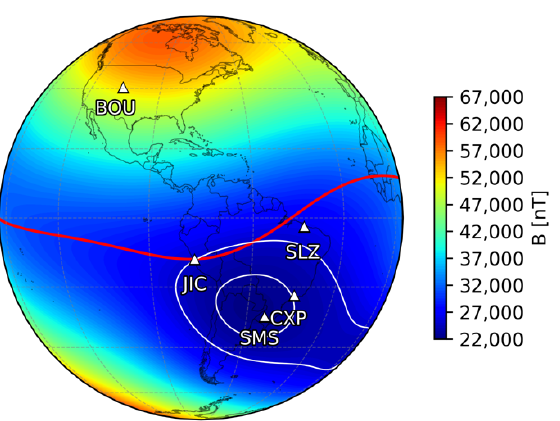
Figure 1. Map showing the instrument sites used in this study. The magnetic equator positions in 2017 (red line) and the SAMA location (white isolines) are also shown. The acronyms for the stations are: BOU, Boulder; JIC, Jicamarca; SLZ, São Luís; CXP, is Cachoeira Paulista; SMS, Santa Maria.